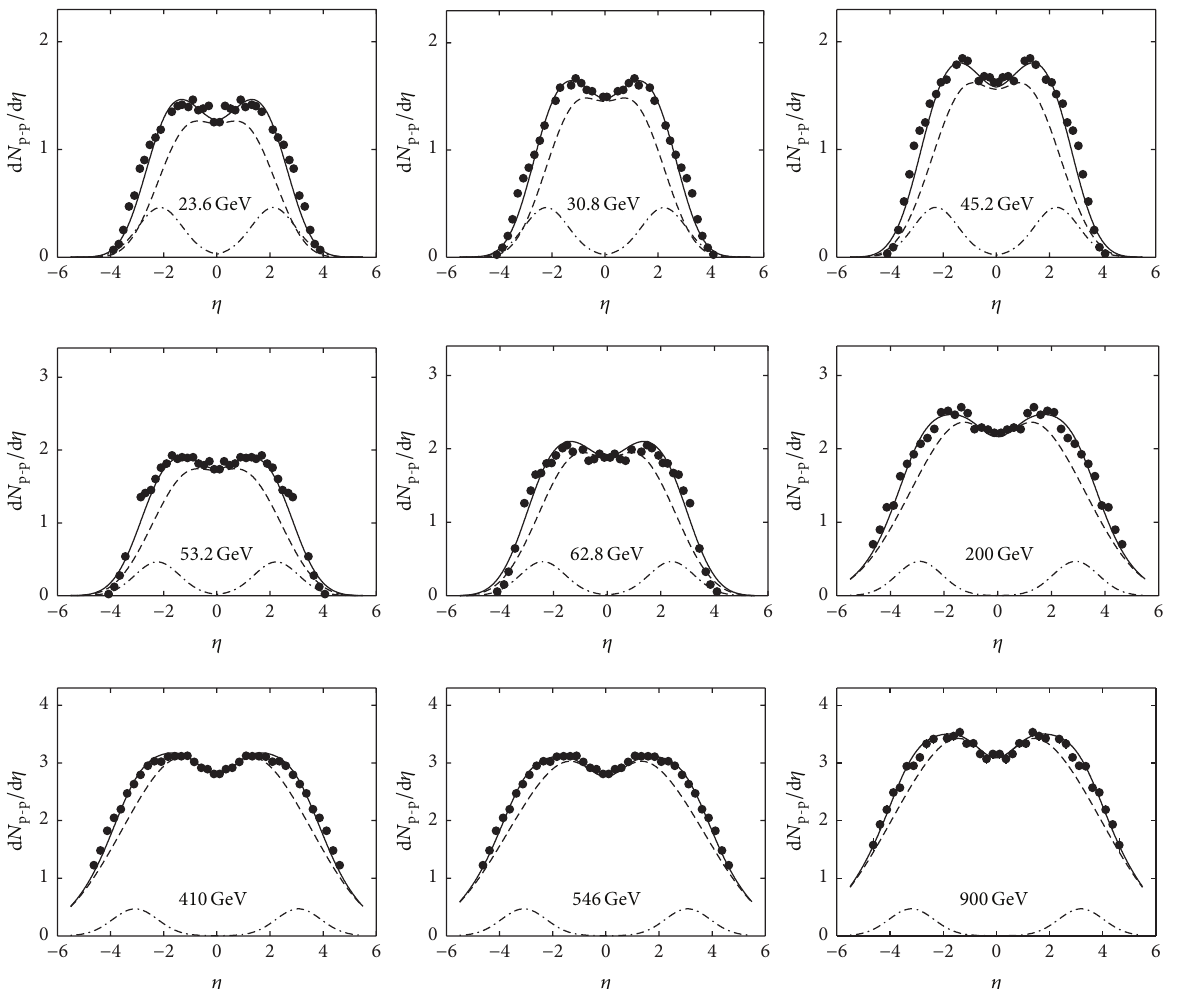
Figure 4: The pseudorapidity distributions of produced charged particles in p-p collisions at energies from √𝑠 = 23.6 to 900 GeV. The solid dots are the experimental measurements [38–40]. The dashed curves are the results from unified hydrodynamics of (19). The dashed-dotted curves are the results from leading particles of (20). The solid curves are the sums of dashed and dashed-dotted